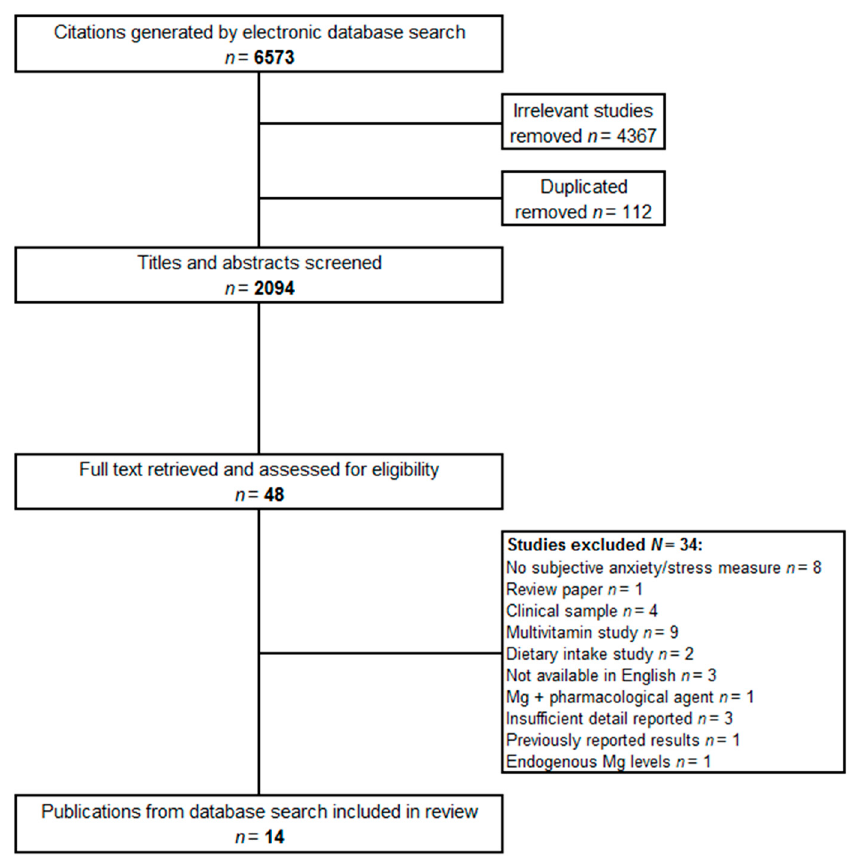
Figure 1. Electronic database study selection summary.